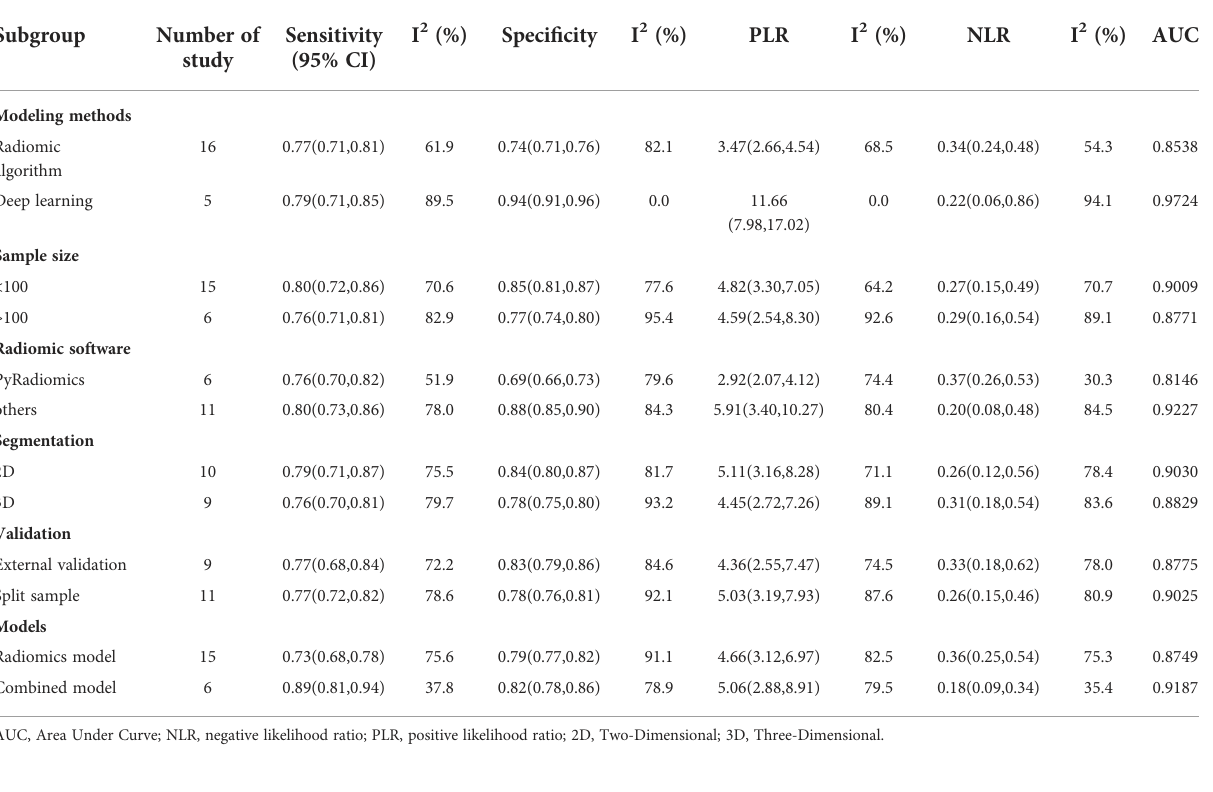
TABLE 3 The results of subgroup analysis.